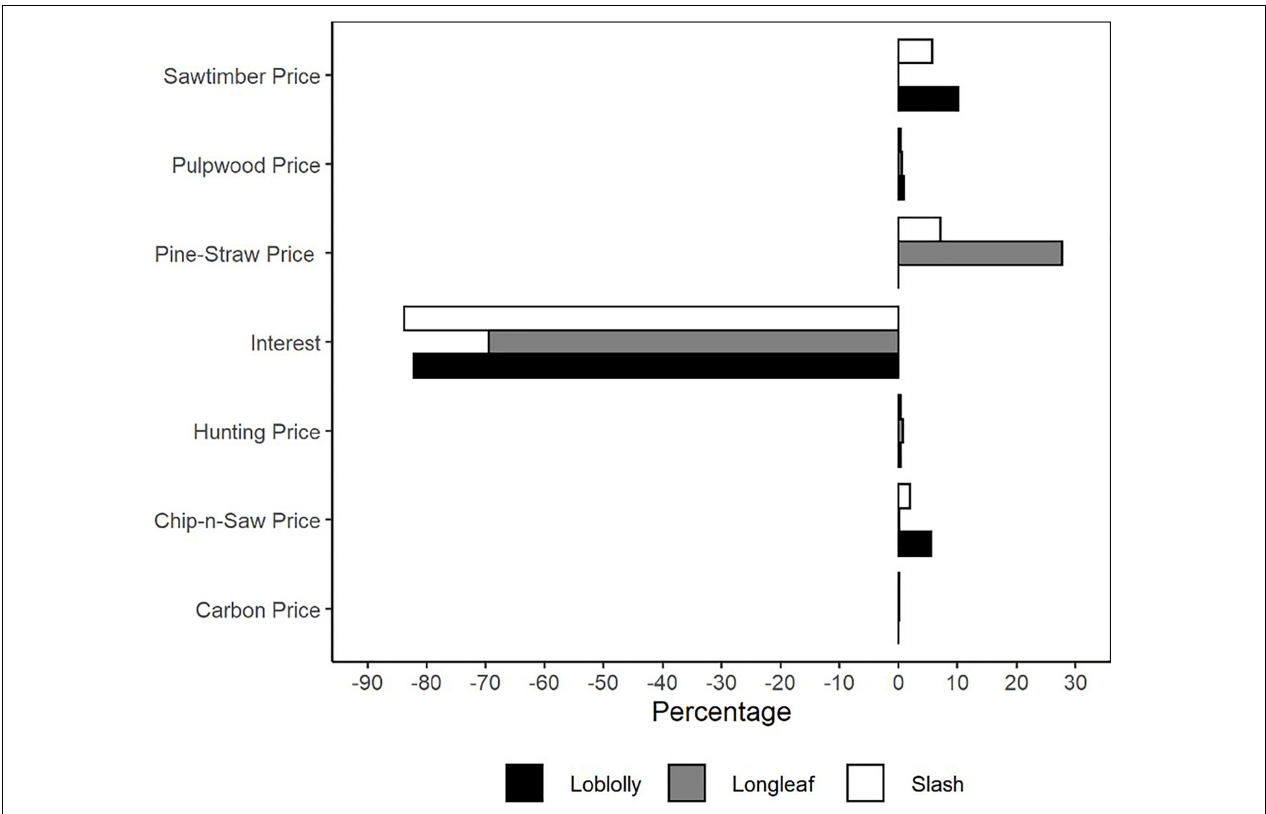
FIGURE 4 | Contribution of input variables to the variance of simulated LEV ( n = 1,000) for loblolly, slash, and longleaf